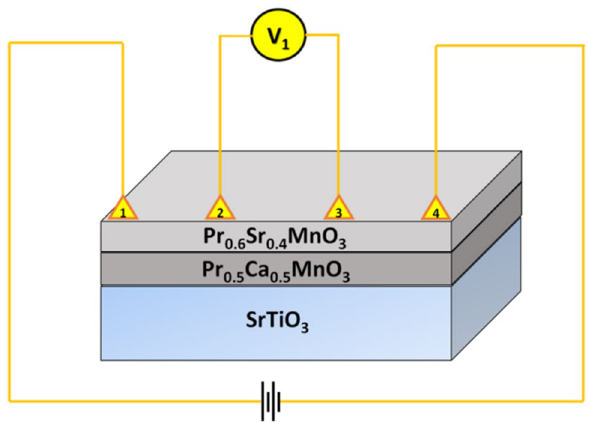
Figure 13. Schematic representation of the heterostructure in linear geometry for magnetoresistance